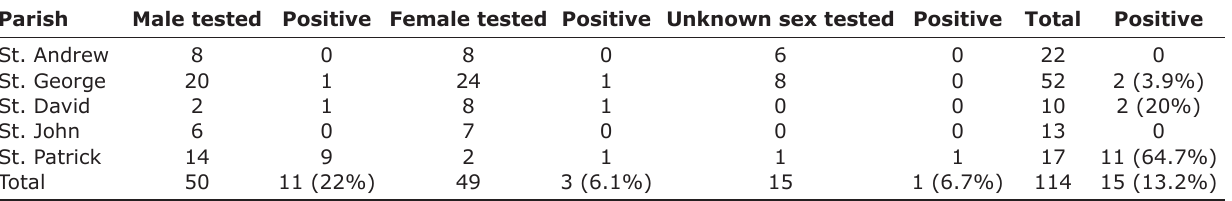
Table-1: Isolation of Salmonella Spp. from red-footed tortoises in Grenada. Parish